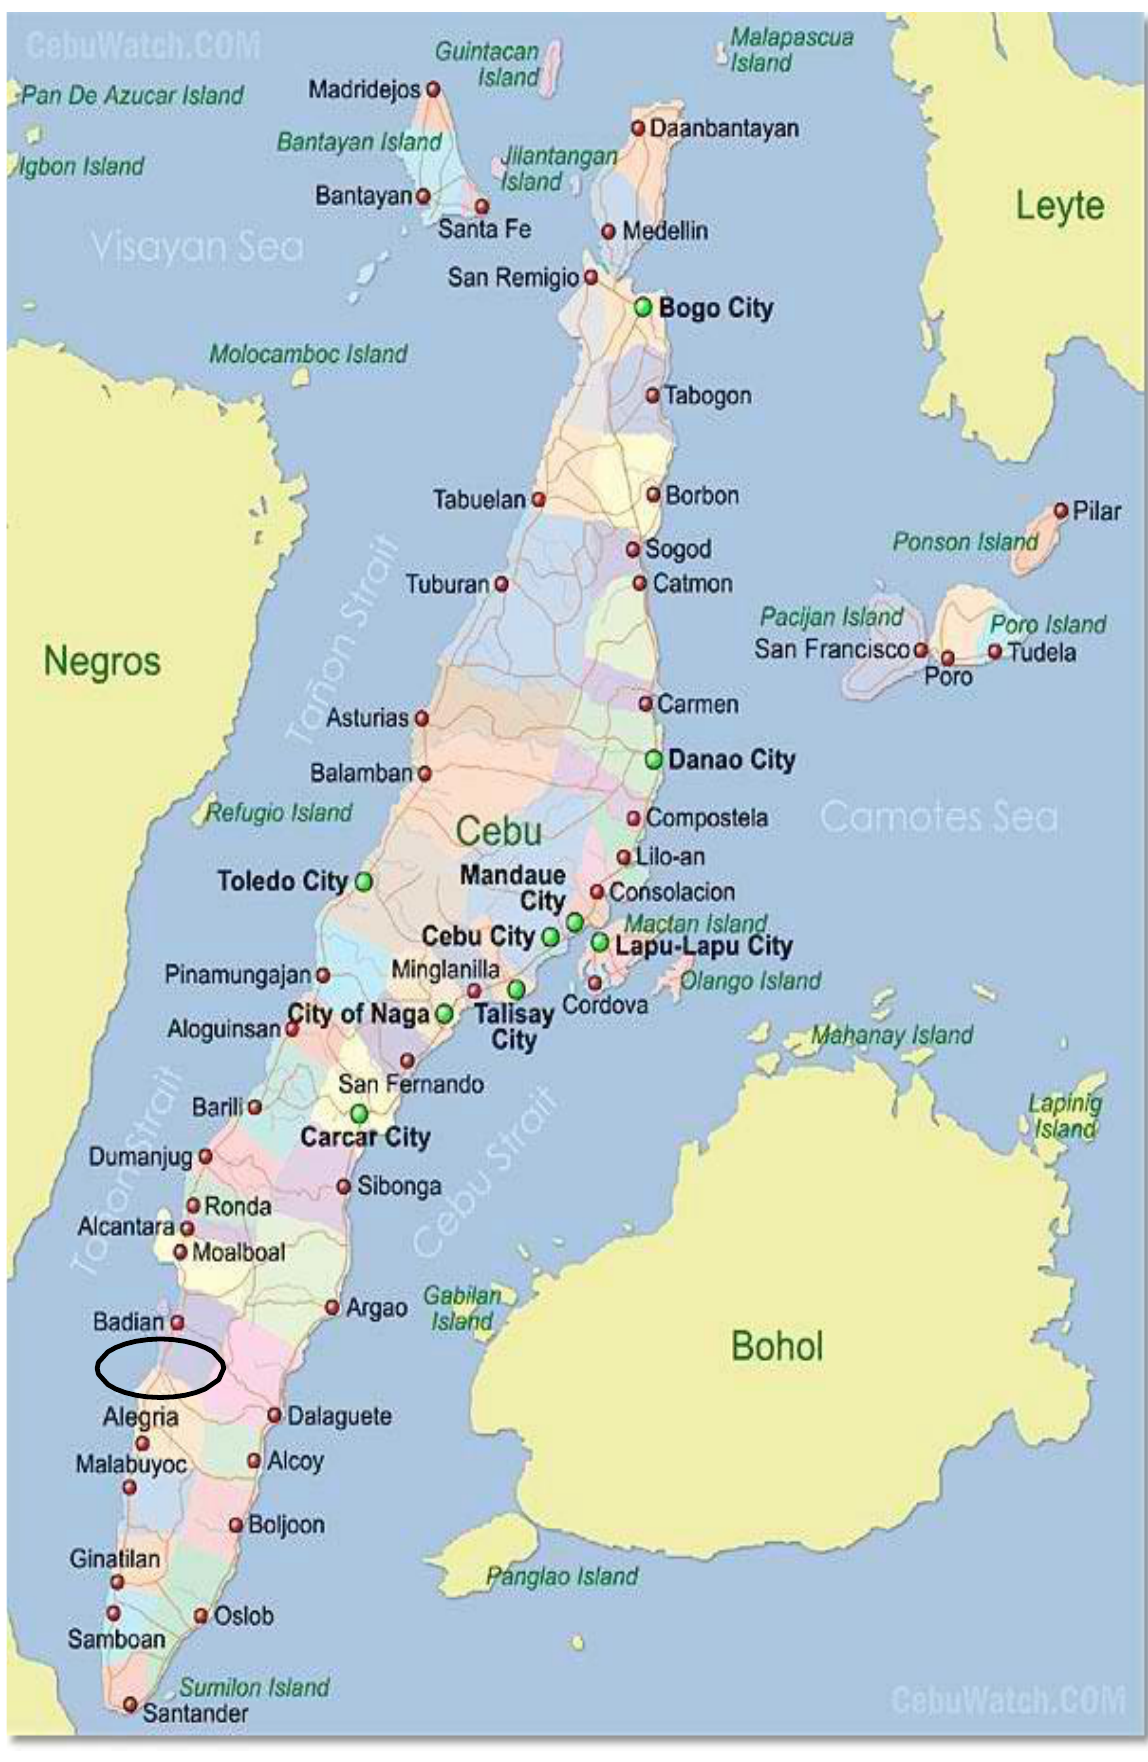
Figure 2. Map Showing where Kawasan Falls is situated in